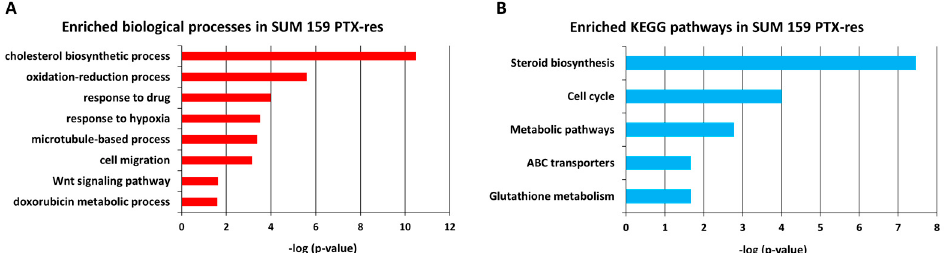
Figure 3. Gene Ontology (GO) analysis of SUM159 paclitaxel-resistant (PTX-res) cells ( A ). The most significantly enriched biological processes for the upregulated DEGs resulting from David analysis. ( B ) The most significantly enriched KEGG pathways for the upregulated DEGs resulting from David